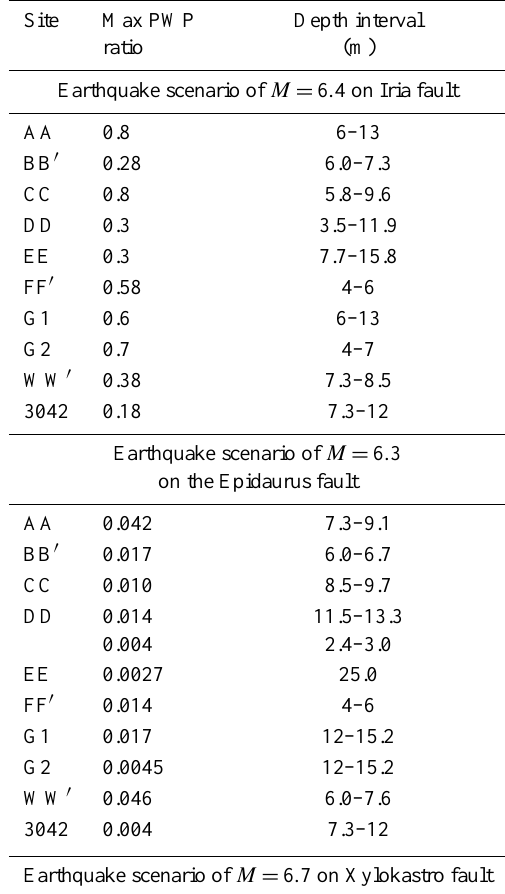
Table 4. Depth distribution of maximum PWP ratio for all investi- gated